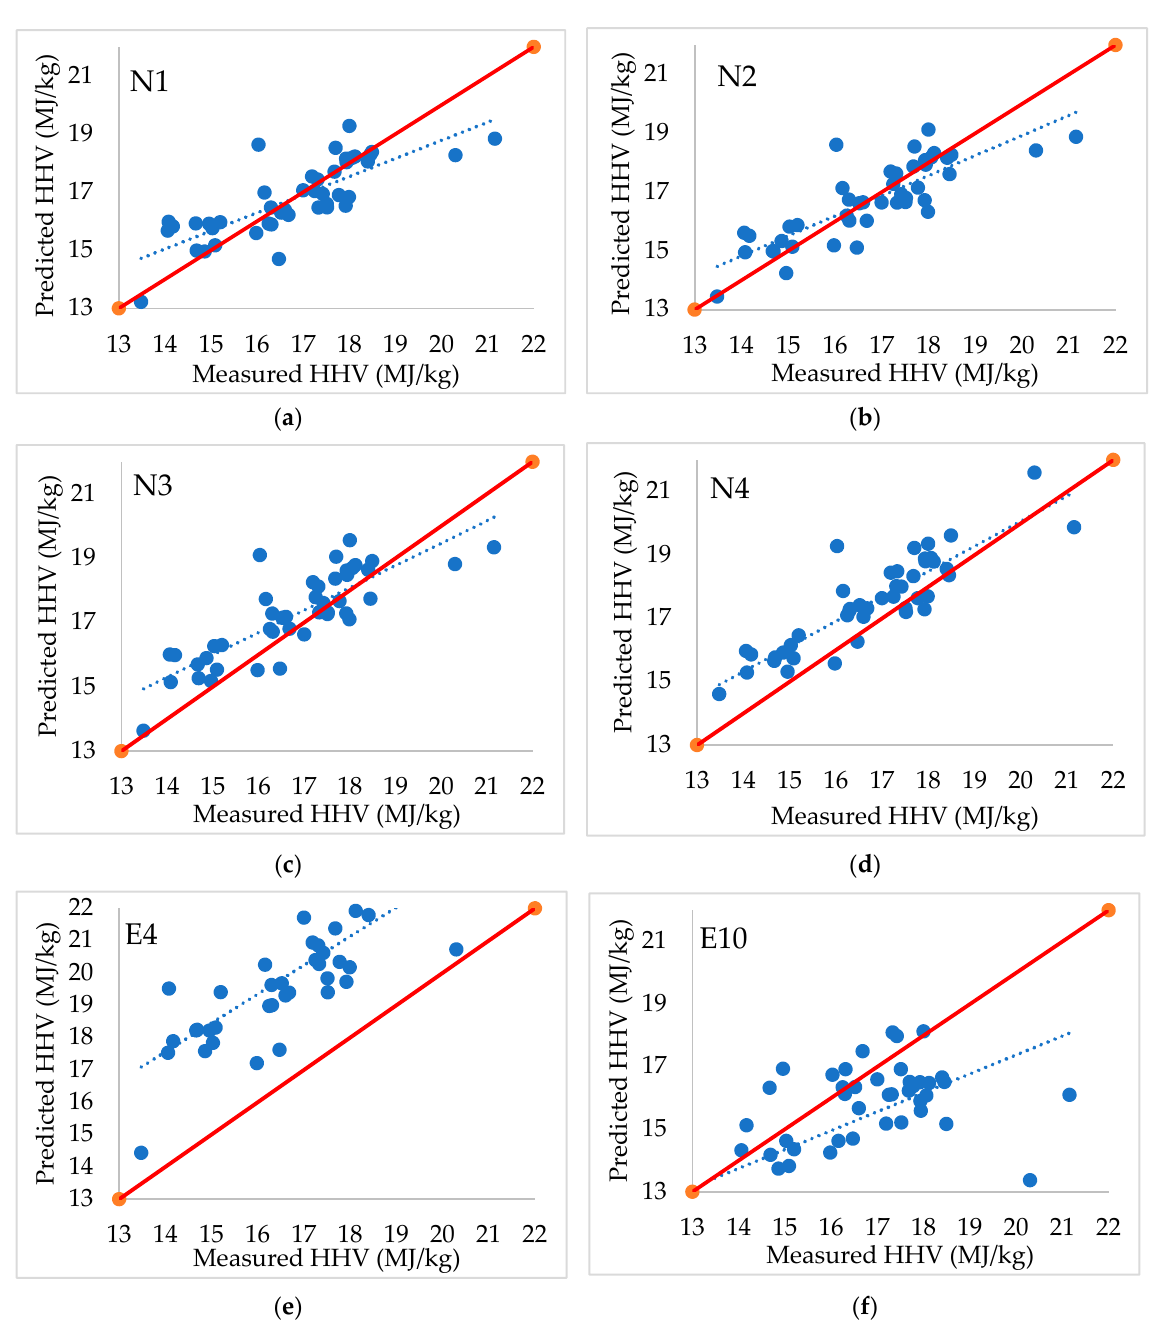
Figure 3. Predicted and measured HHV results using the new and existing HHV models, respectively: ( a ) N1; ( b ) N2; ( c ) N3; ( d ) N4; ( e ) E4; ( f ) E10. The red lines represent the points where HHV predicted = HHV experimental .